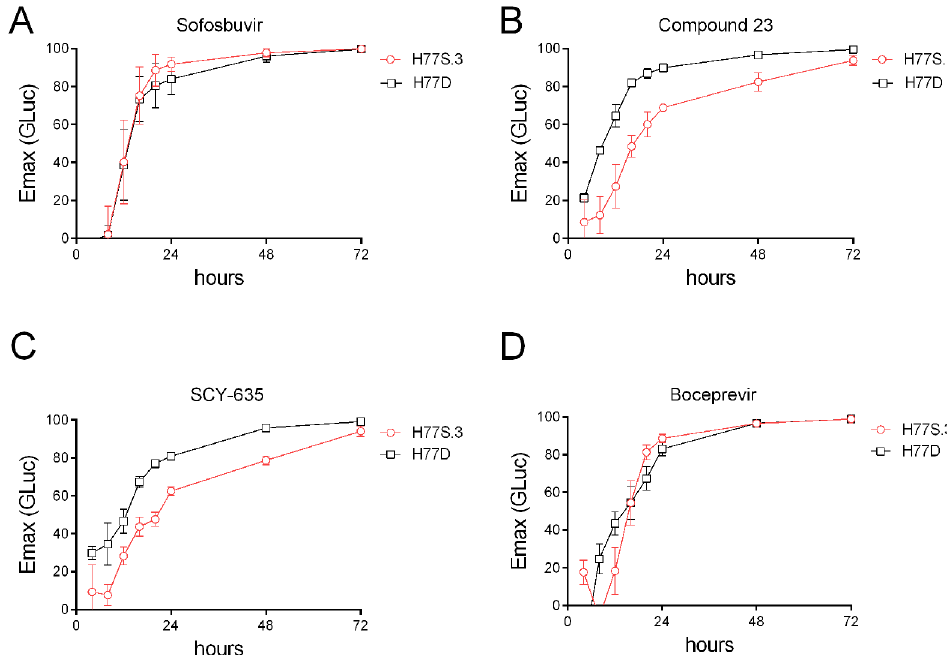
Fig 3. Differencesin kinetics of virus inhibition in H77S.3- vs H77D-infected cells are observed with host-targeting antiviral drugs that block membranous web formation but not with the NS5B RdRP inhibitor sofosbuvir or the NS3/4A protease inhibitor boceprevir. Maximum % inhibition(E max ) at different time points after additionof (A) sofosbuvir, (B) Compound23: a small moleculeinhibitorof PI4KIII α , (C) SCY- 635: a cyclophilininhibitor,or (D) boceprevir, to Huh7.5 cells infected with H77S.3/GLuc2A or H77D/GLuc2A.